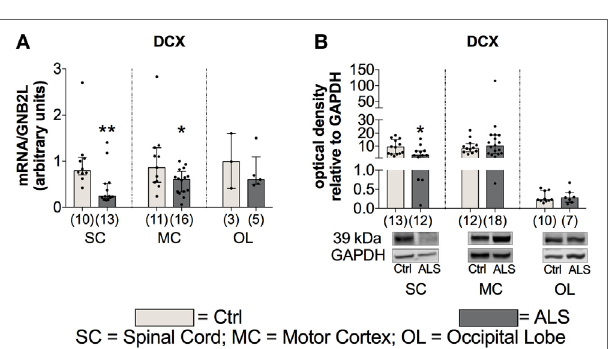
FigUre 11 | Tissue concentration of neurogenesis marker is reduced in Amyotrophic lateral sclerosis (ALS) patients within the spinal cord (SC) and motor cortex (MC) indicated by reduced DCX mRNA and protein expression in the SC and a decreased DCX mRNA expression within the MC (a, b) . Expression levels within the occipital lobe (OL) were unchanged on mRNA and protein level. * p < 0.05 vs. controls (Ctrl); ** p < 0.01 vs. Ctrl. Numbers of patients are given in brackets; All parameters were tested for Gaussian distribution using D’Augostino­Pearson omnibus normality test. Two­tailed Mann–Whitney test, data represent median with interquartile range. DCX protein expression levels were quantified and represented relative to the expression levels of the housekeeping protein